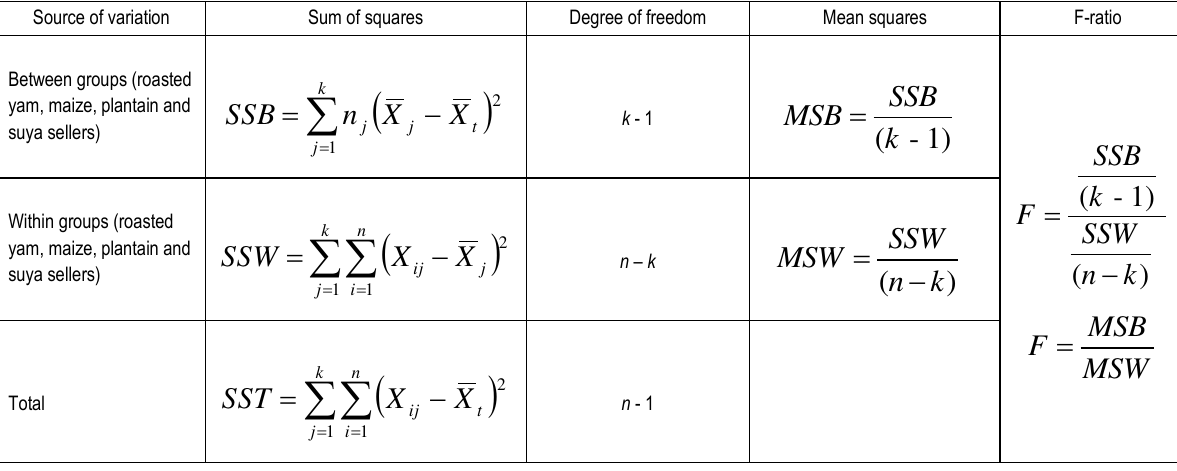
Source of variation Sum of squares Degree of freedom Mean squares F-ratio Between groups